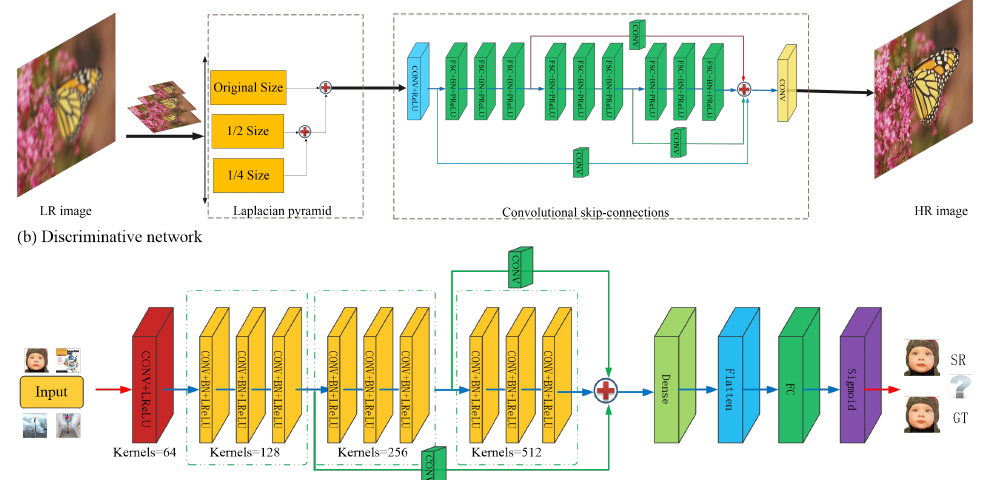
Figure 1. Our architecture of the Enhanced Generative Adversarial Network. The structure of the generative network and the discriminative network are depicted in ( a , b ), where ( a ) contains the Lapla- cian pyramid framework and the convolutional skip-connections, and ( b ) contains three modules of the convolutional layers, BN and